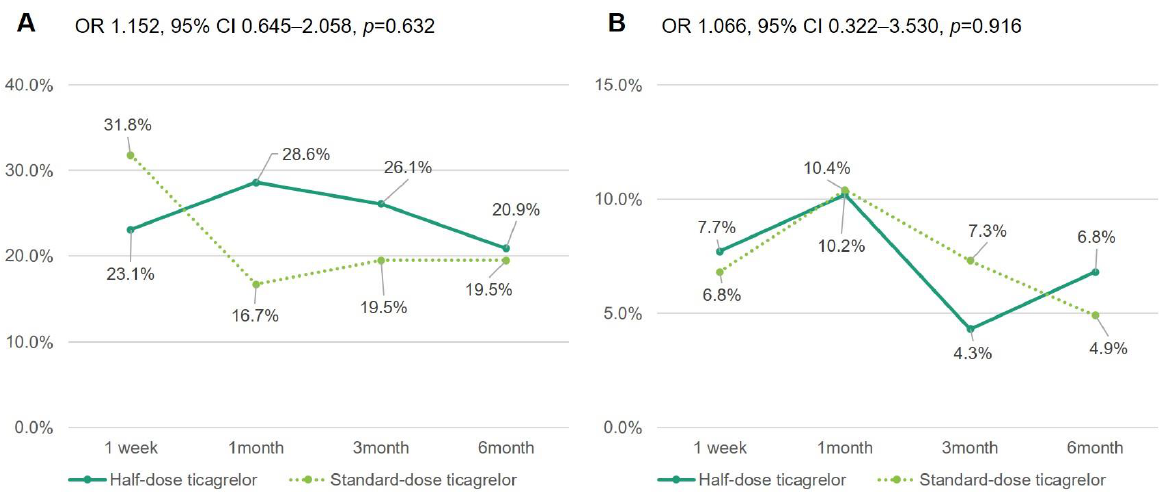
Figure 3. Incidence and temporal change of mild dyspnea (Borg score 1–2) ( A ) and moderate-to-severe dyspnea (Borg score ≥ 3) events ( B ) over time during half- vs. standard-dose ticagrelor. Borg score measured Borg scale category-ratio 10. Exponentiation of the B coefficient was calculated with standard-dose ticagrelor as a reference. CI = confidence interval; OR = odds ratio.